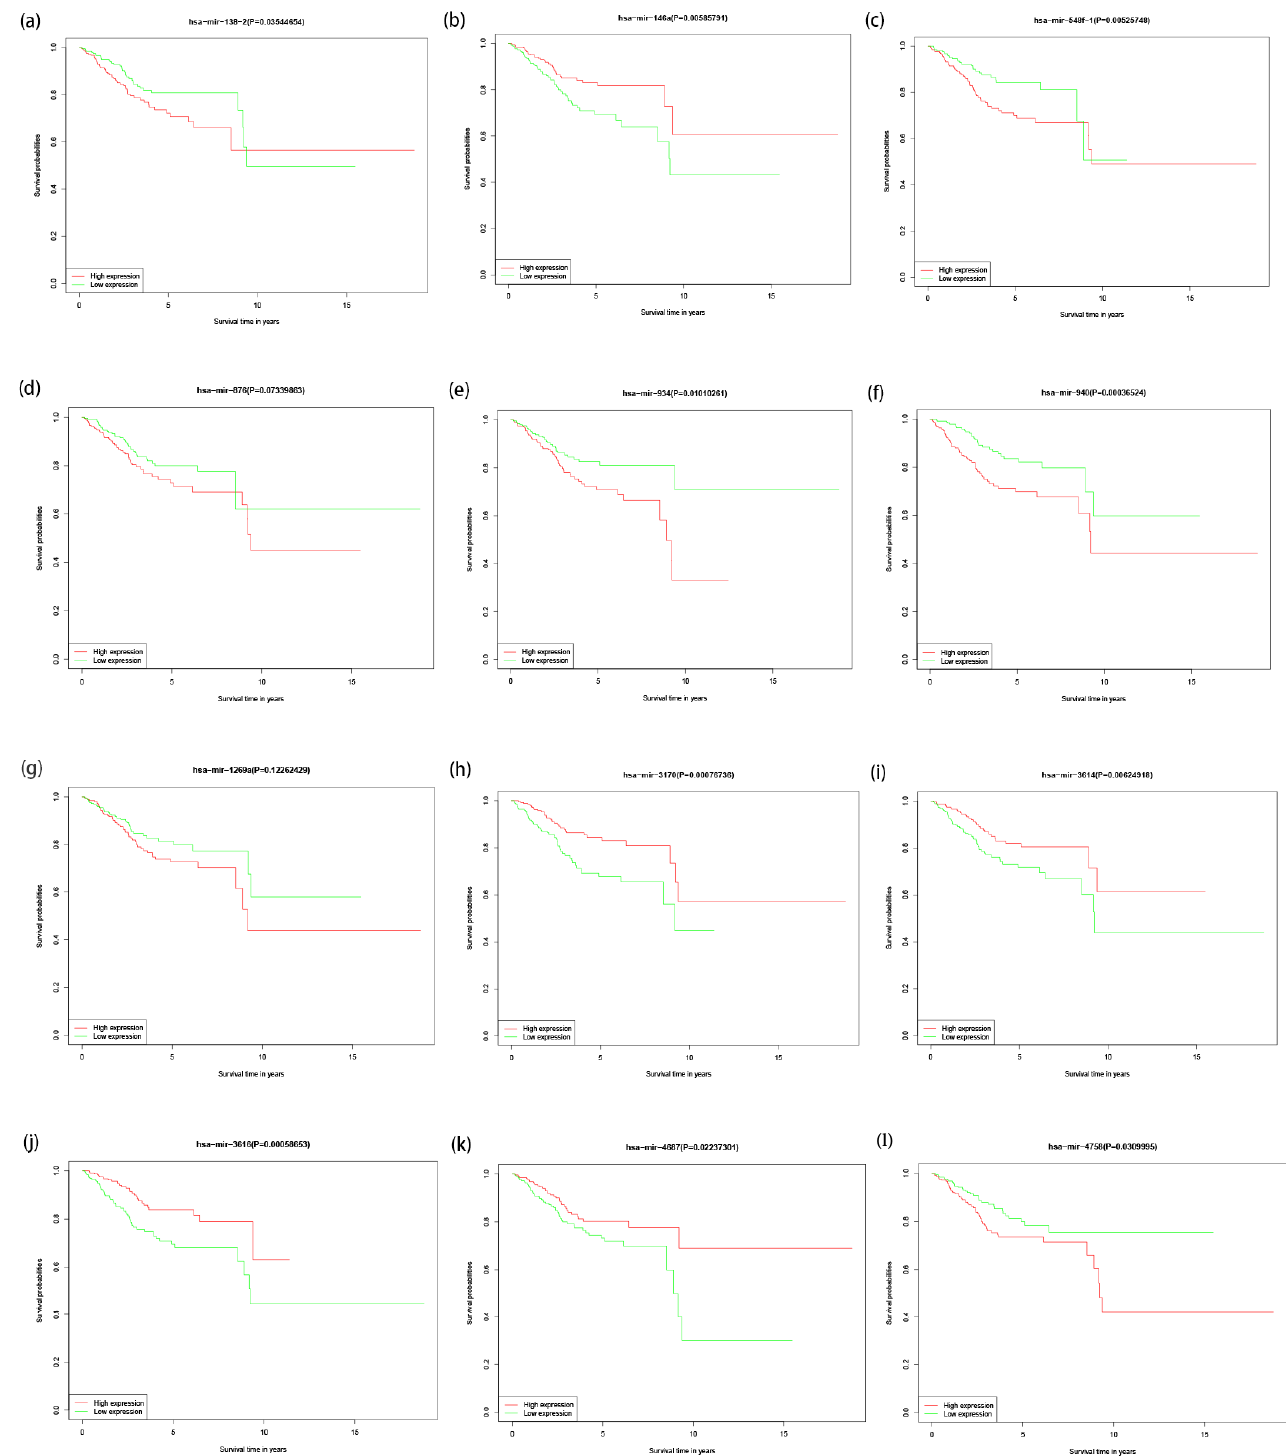
Figure 8. Survival analysis for EC patients with high and low expression of 12 miRNAs: ( a ) hsa- mir-138-2; ( b ) hsa-mir-146a; ( c ) hsa-mir-548f-1; ( d ) hsa-mir-876; ( e ) hsa-mir-934; ( f ) hsa-mir-940; ( g ) hsa-mir-1269a; ( h ) hsa-mir-3170; ( i ) hsa-mir-3641; ( j ) hsa-mir-3616; ( k ) hsa-mir-4687; ( l ) hsa-